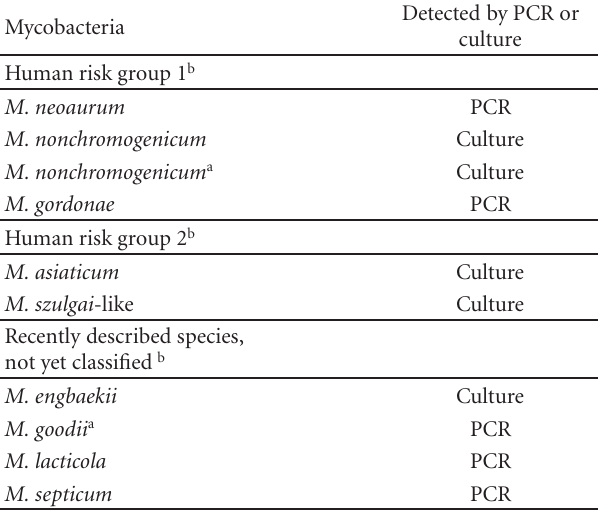
Table 6: Mycobacteria detected in cow milk on the cattle farms.